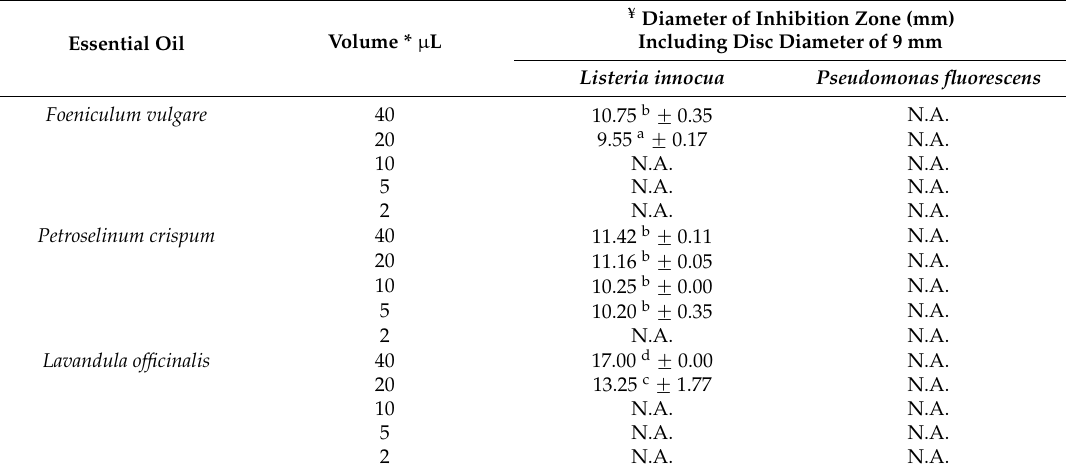
Table 7. The volume effect (VE) of organic fennel, parsley, and lavender essential oils from Spain on the inhibition of Listeria innocua CECT910 and Pseudomonas fluorescens CECT